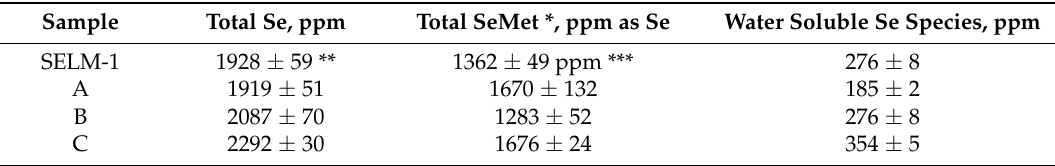
Table 1. The results of the total Se, SeMet, and water-soluble selenium species determination in the studied